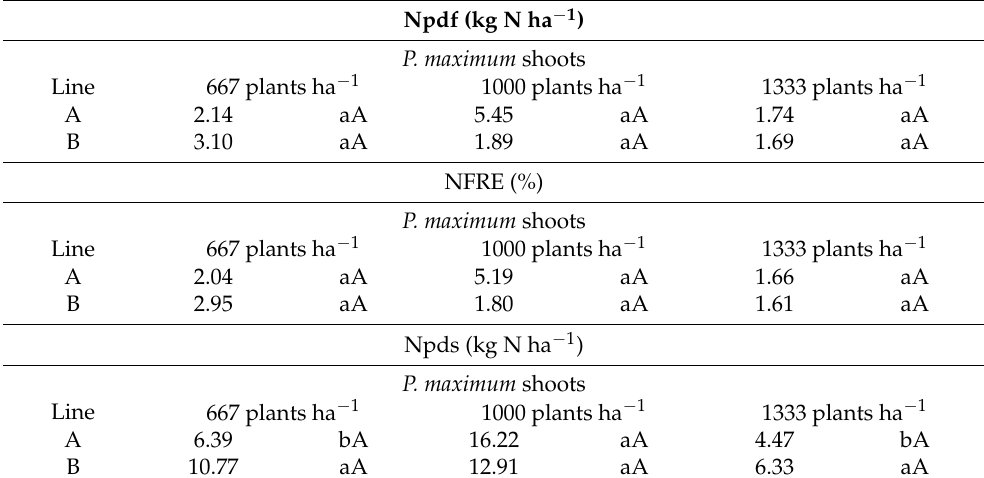
Table 2. Nitrogen in the plant derived from fertilizer (Npdf), N fertilizer recovery efficiency (NFRE) and N in the plant derived from soil (Npds) in shoots of P. maximum cv. Massai from three agrisilvi- culture systems with 667, 1000 and 1333 plants of Gliricidia sepium ha − 1 . Panicum maximum shoots were collected at lines close to the G. sepium plants (A) and in the middle of the plots